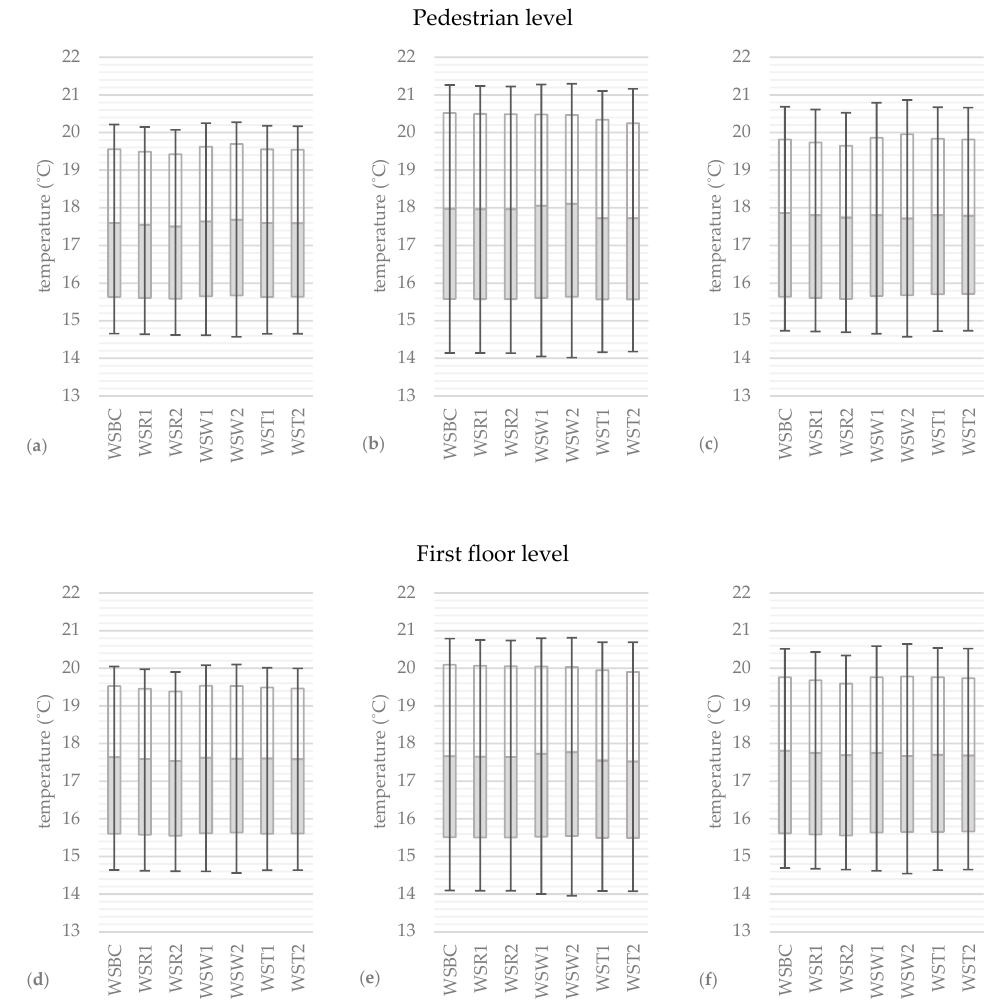
Figure 7. Air temperature in a typical building quarter during the warm period (( a ) interior of the building quarter at 1.4 m height, ( b ) canyon with the axis parallel to the direction of air inflow at 1.4 m height, ( c ) canyon with the axis perpendicular to the direction of air inflow at 1.4 m height, ( d ) interior of the building quarter at 5 m height, ( e ) canyon with the axis parallel to the direction of air inflow at 5 m height, ( f ) canyon with the axis perpendicular to the direction of air inflow at 5 m height).